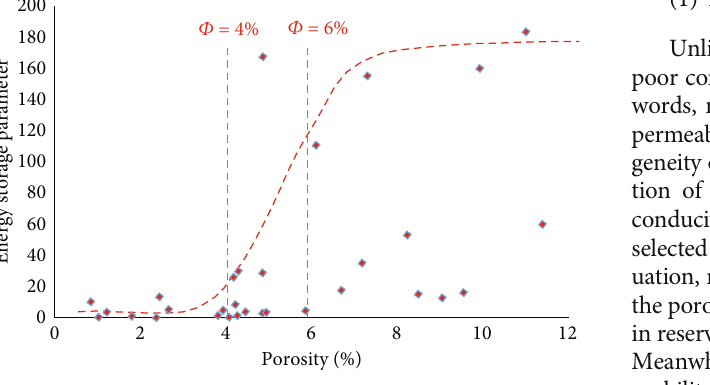
Figure 4: Relationship between porosity and the energy storage